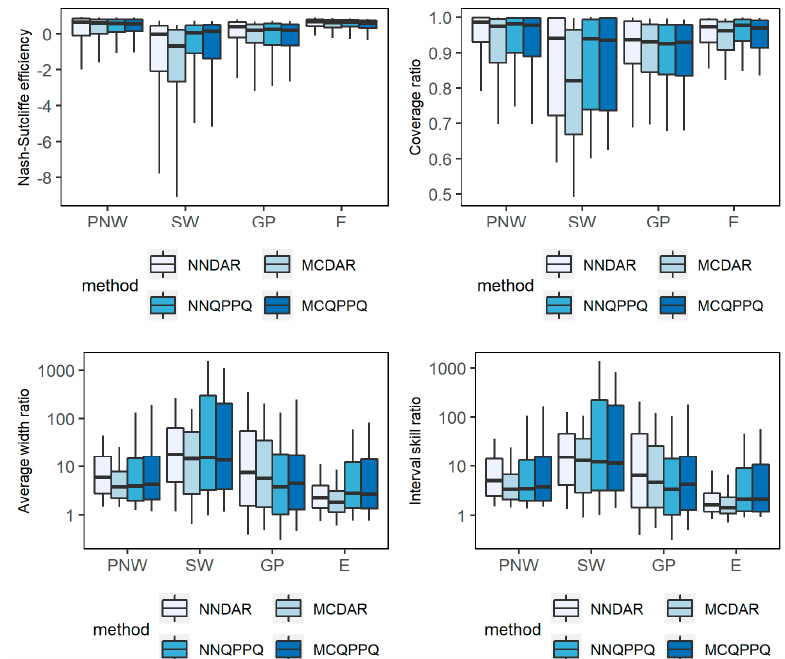
Figure 3. Distribution of streamflow simulation and uncertainty intervals performance for 1331 validation streamgage sites in four regions: Pacific Northwest and mountains (PNW), Southwest (SW), Great Plains (GP), and Eastern U.S. (E). Boxplot whiskers extend to the 10th and 90th percentiles of the distribution, box ends represent the 25th and 75th percentiles, and the horizontal line represents the median.